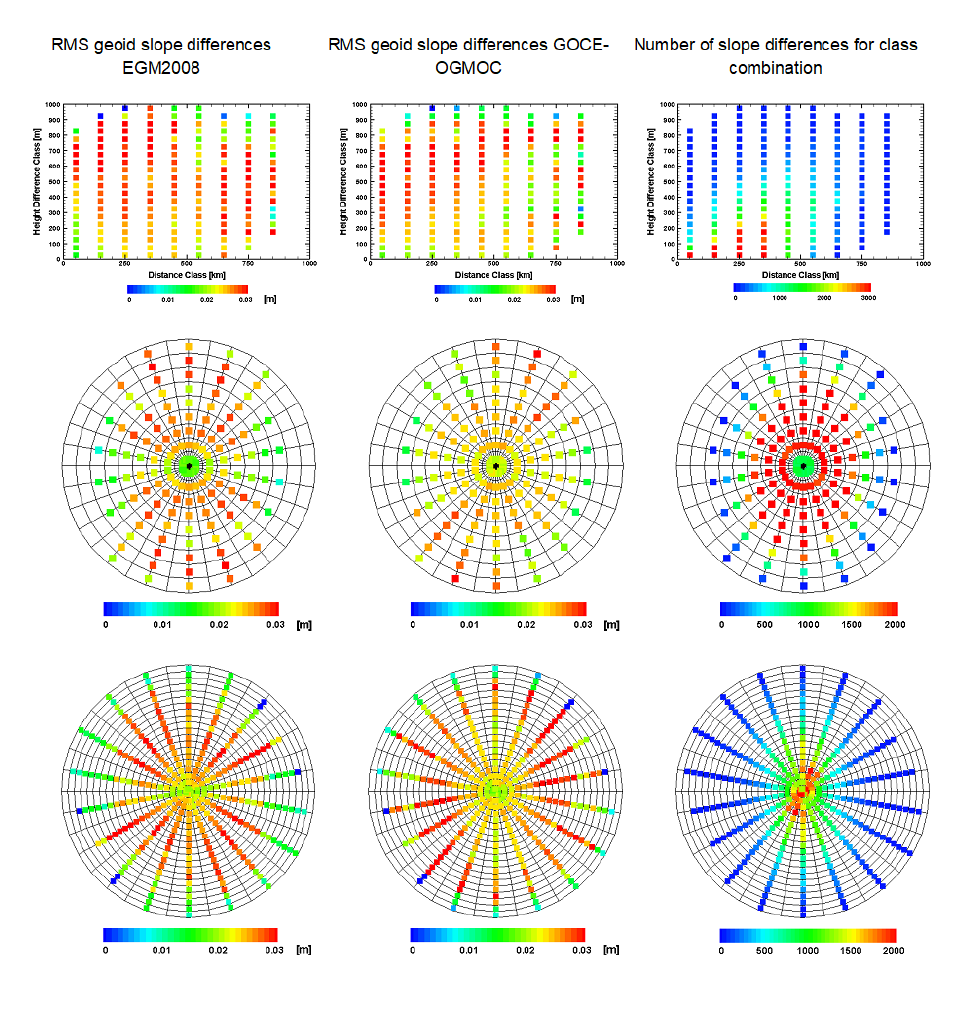
Fig. 6. RMS of geoid slope differences for the EGM2008 and GOCE-OGMOC high resolution models with full resolution (degree 2190) and GNSS-levelling points in Germany (data set G07). The RMS value is computed and shown for the combination of two classes. 1. Row: Dis- tance and height differences, 2. Row: Distance and orientation (circles represent distance classes in steps of 100 km), 3. Row: Height differ- ences and orientation (circles represent height difference classes in steps of 50